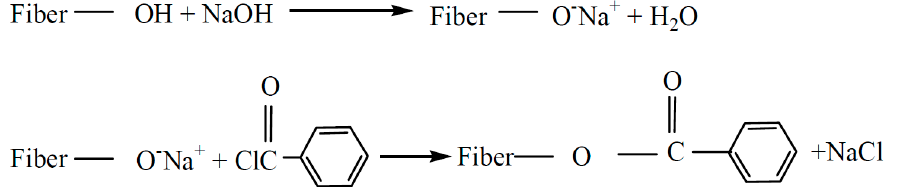
Figure 3. A possible reaction between cellulosic-OH groups and benzoyl chloride. Adapted from Ref. [152]. Creative Common CC BY license.